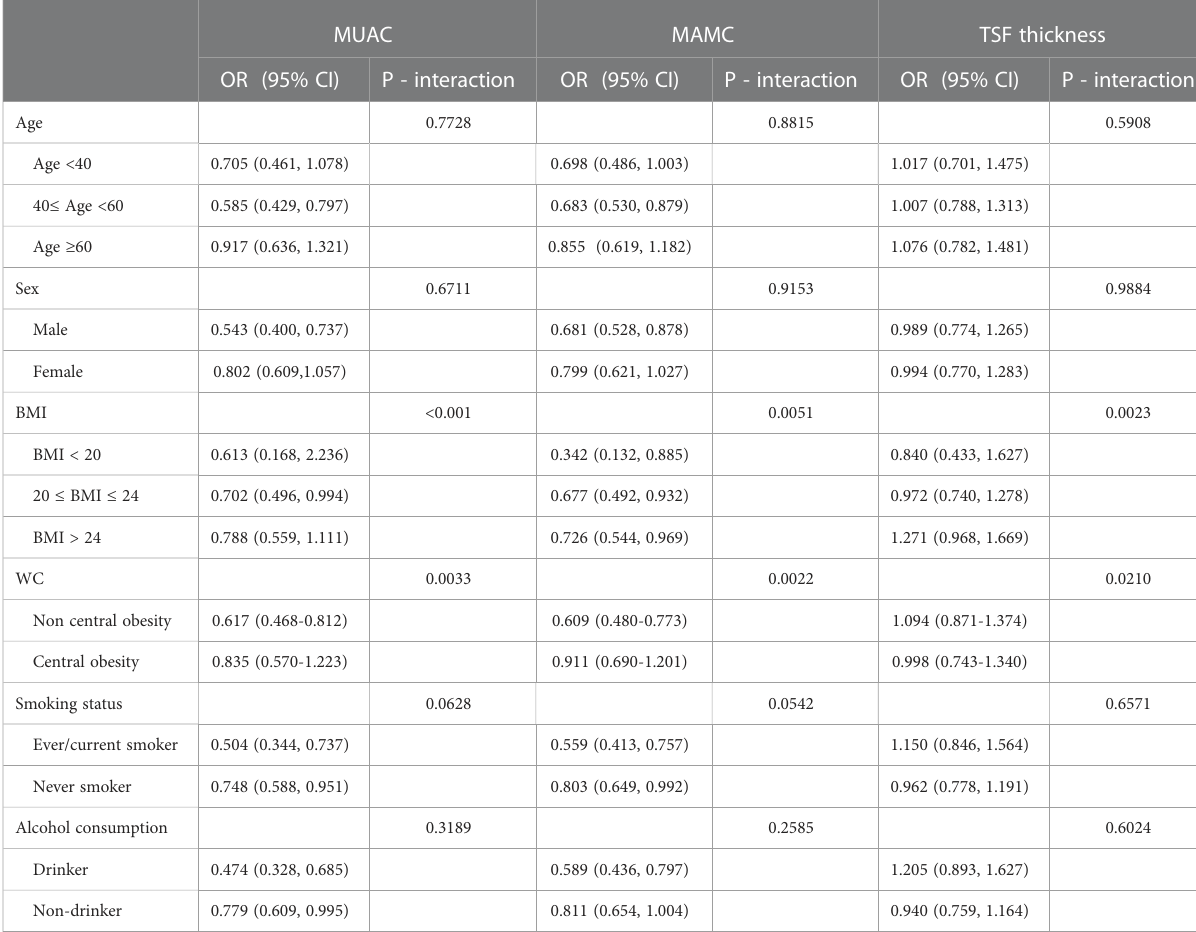
TABLE 3 Association between mid-upper measurements and insulin resistance strati fi ed by age, sex, BMI, WC, smoking status, and alcohol